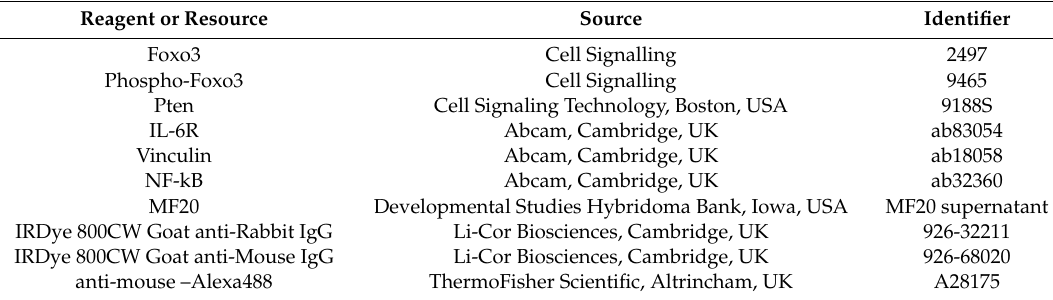
Table 2. List of antibodies used in the